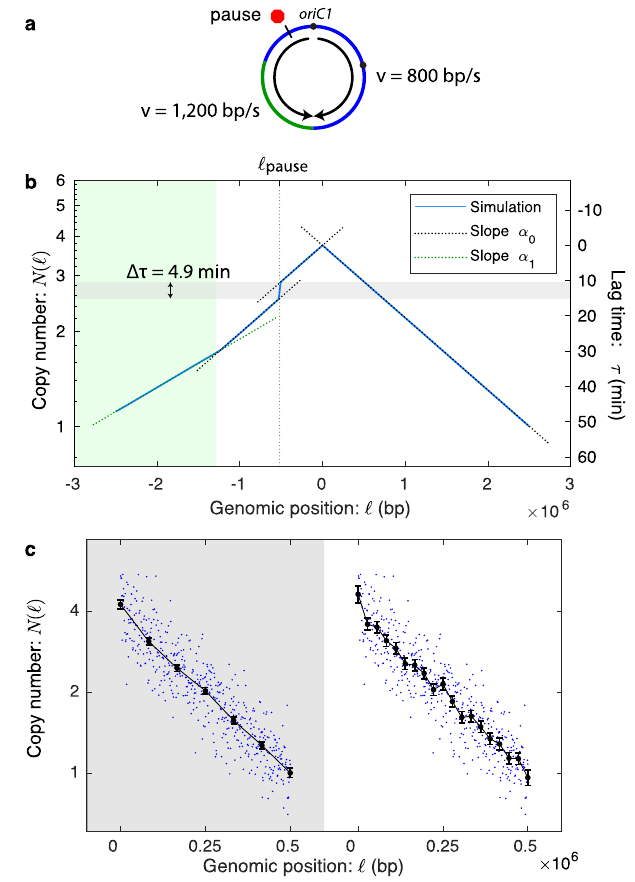
Fig. 7 | Analysis of simulated data. a A schematic of the simulated chromosome. Replication initiates at the origin, pauses at a locus (red octagon) on the left arm and the velocity is increased on the lower left arm (green). b Simulated marker frequency obeys the log-slope law. The stochastic simulation generates a marker- frequency curve (blue). The model is stochastic in the timing of replication initia- tion as well as the fork dynamics and it includes two regions (blue and green) with different fork velocities as well as a pause with a stochastic lifetime (see the Ter- minus 4 model in the Supplementary Notes). In spite of the stochasticity, it obeys the log-slope law locally, Equation (16). Furthermore, the inferred lag-time pause (4.9min) is predicted by the exponential mean, Equation (2). c Tradeoff between genomic resolution and velocity precision. As the spacing between knots decrea- ses, increasing the genomic resolution, the error in the velocity measurement increases. These plots are generated with n =500 simulated data points that are independently Gaussian-distributed about their means. The mean values corre- spond to a model with 16 genomic segments that each have different fork velo- cities. Data are presented as mean